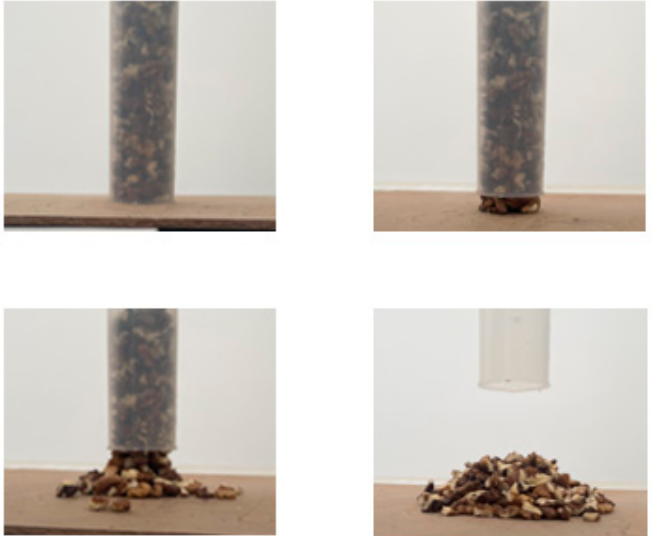
Figure 1. Measurement of repose angle for walnut kernels.